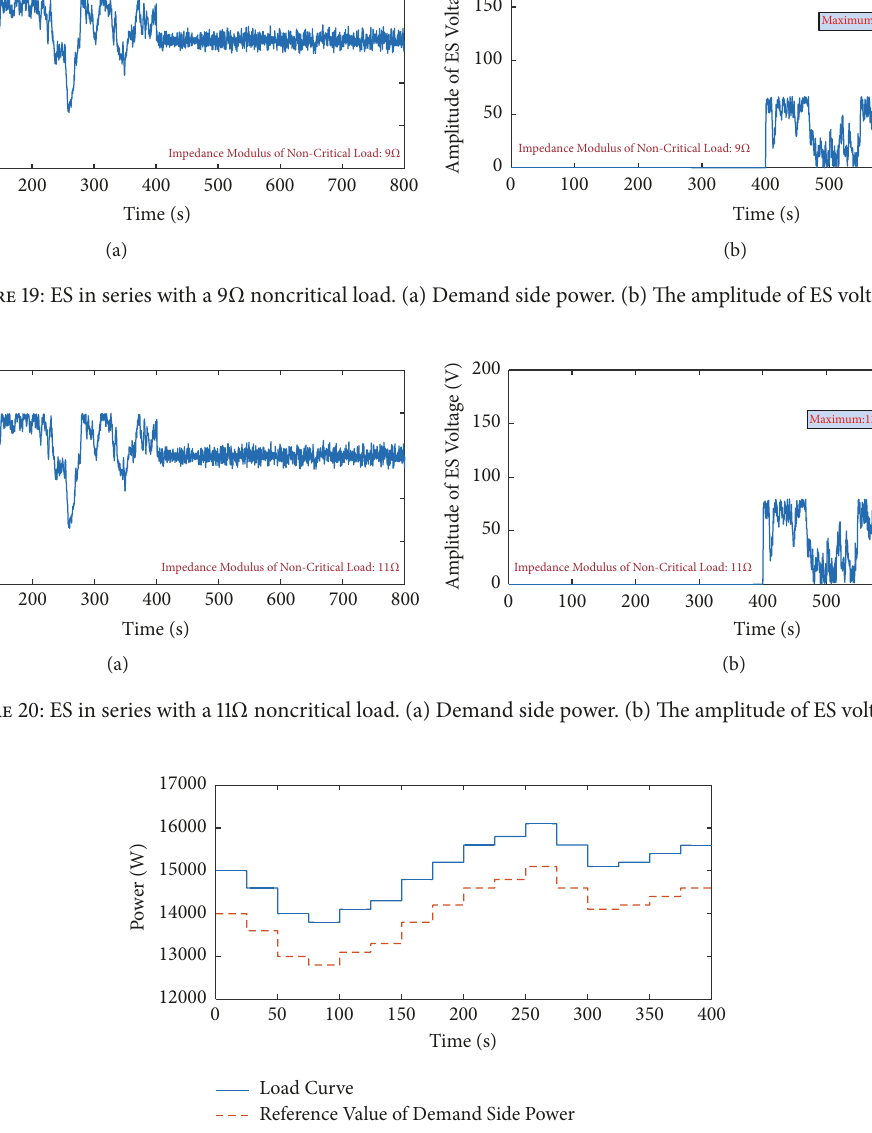
Figure 21: The total load curve and the reference value curve of demand side